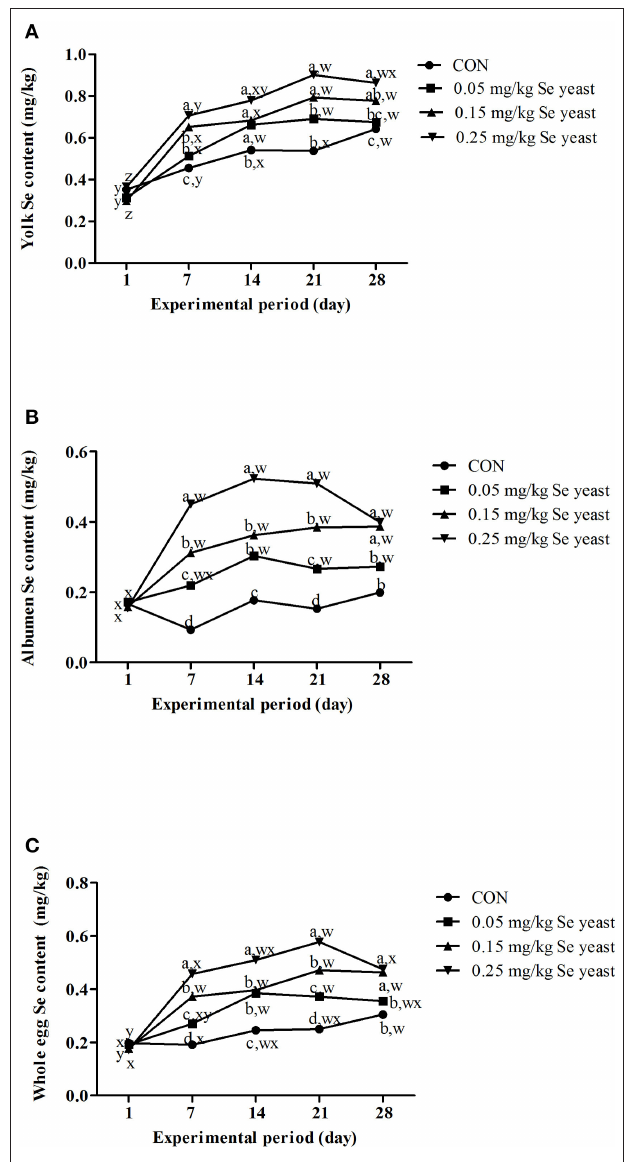
FIGURE 1 | (A) Effect of dietary Se yeast supplementation on the dynamic change of yolk Se contents (mg/kg, fresh weight basis) during the 28-d feeding period. (B) Effect of dietary Se yeast supplementation on the dynamic change of albumen Se contents (mg/kg, fresh weight basis) during the 28-d feeding period. (C) Effect of dietary Se yeast supplementation on the dynamic change of the whole egg Se contents (mg/kg, fresh weight basis) during the 28-d feeding period. CON = the basal diet with 0.15mg Se/kg from premix, 0.05mg/kg Se yeast = the basal diet plus 0.05mg/kg of Se from Se yeast, 0.15mg/kg Se yeast = the basal diet plus 0.15mg/kg of Se from Se yeast, 0.25 mg/kg Se yeast = the basal diet plus 0.25mg/kg of Se from Se yeast. Values on the same day with different superscripts (a, b, c, d) are significantly different at p < 0.05. Values on the same line with different superscripts (w, x, y, z) are significantly different at p < 0.05. Egg Se contents for each treatment data on the same experimental day are means of 6 replicates (2 eggs per